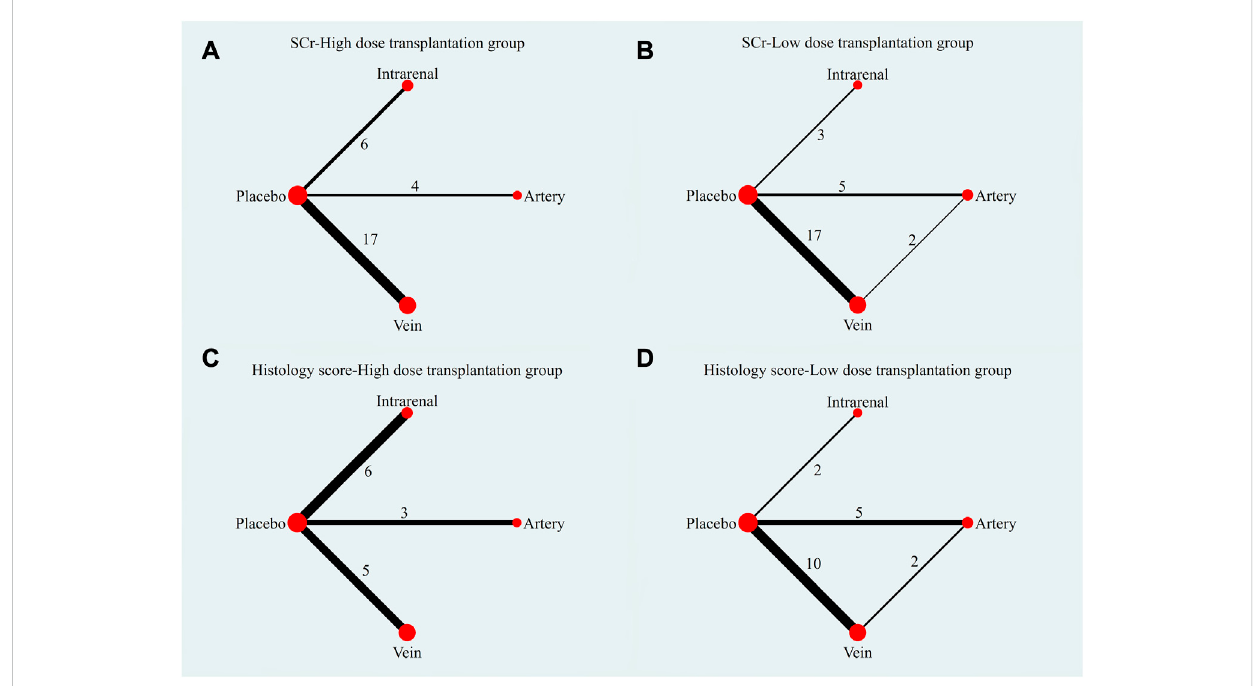
FIGURE 3 Evidence plot of different transplant routes. (A) SCr-High dose transplantation group. (B) SCr-Low dose transplantation group. (C) Histology score- High dose transplantation group. (D) Histology score-Low dose transplantation